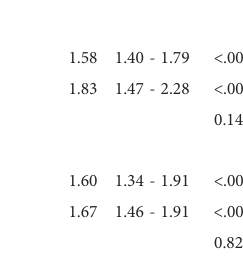
TABLE 4 Sensitivity analysis for the risk of primary Sjogren ’ s syndrome following HPV infections.